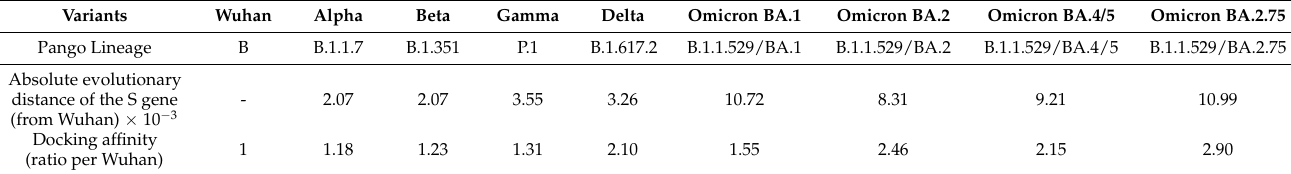
Table 1. The evolutionary distance of the S gene and the docking affinity of the spike protein with ACE2 (ratio per Wuhan